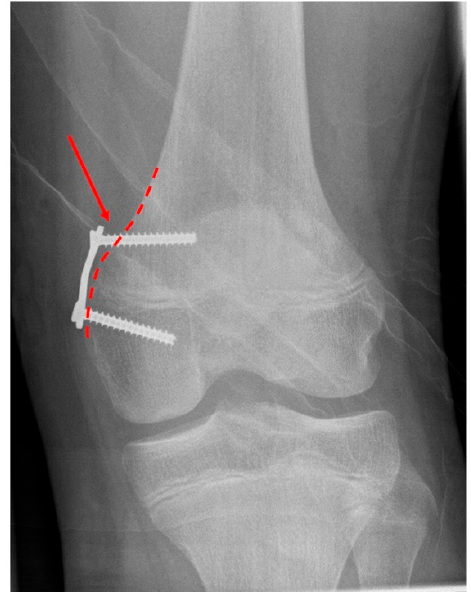
Figure 4. Metaphyseal plate position with pull-out and loss of initial contouring of the metaphyseal screw. Dashed line outlines the bone structure and cortical contour. Arrow pointing at the pull-out and loss of initial contouring resulting in lift-o ff of the plate at the metaphyseal end.